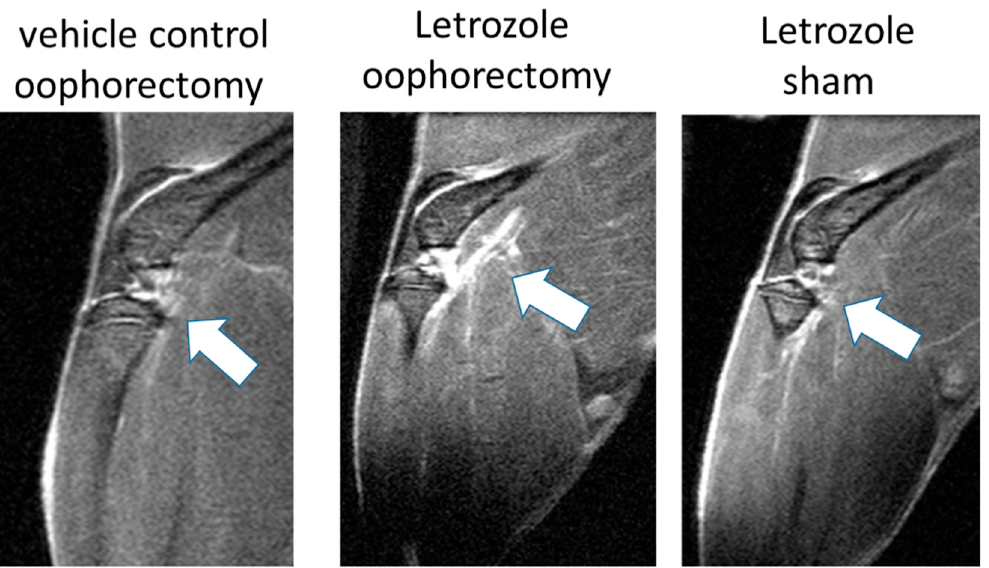
Figure 2. Enhanced MRI signals detected in the legs of mice receiving aromatase inhibitor treatment. Female NFkB-RE-luc mice were injected subcutaneously with the aromatase inhibitor letrozole (10 µ g/mouse/day) or vehicle control (0.3% hydroxypropyl cellulose) following oophorectomy or control surgery (sham). MRIs were conducted on live mice after 5 weeks of treatment. Enhanced signals (white arrows) were observed in knees and surrounding muscle tissue via MRI (T1-weighted) with letrozole treatment, and these responses were detected in NFkB-RE-luc mice irrespective of the oophorectomy